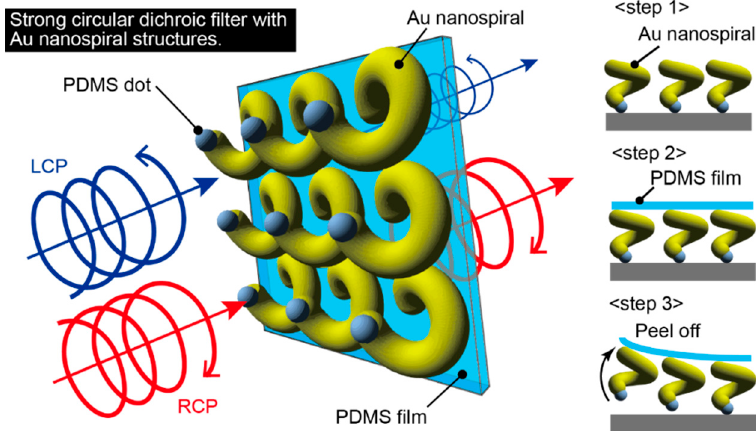
Figure 1. Proposed circular dichroic film at a visible wavelength with Au nanospiral structures transferred on a polydimethylsiloxane (PDMS) thin film.